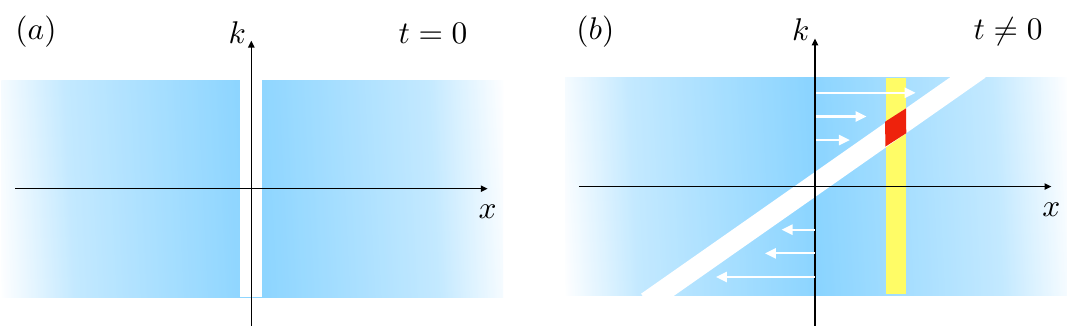
Figure 6: Wigner probability distribution for the homogeneous Fermi gas on an in- finite line. Panel (a): we remove a particle at time t = 0 (white slice). Panel (b) The slice corresponding to the removed particle evolves. At time t we want to create a particle in x (yellow slice). The probability of doing it it proportional to the area shared by these two slides (red